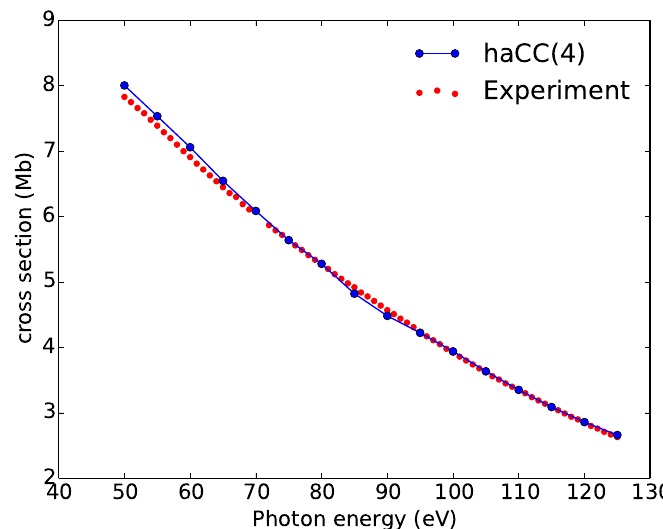
Figure 1. One-photon ionization cross-sections of Neon as a function of photon energy from haCC and from experiments [22]. haCC(4): Ionic basis consists of both 1 s 2 2 s 2 2 p 5 states and 1 s 2 2 s 2 p 6 state.